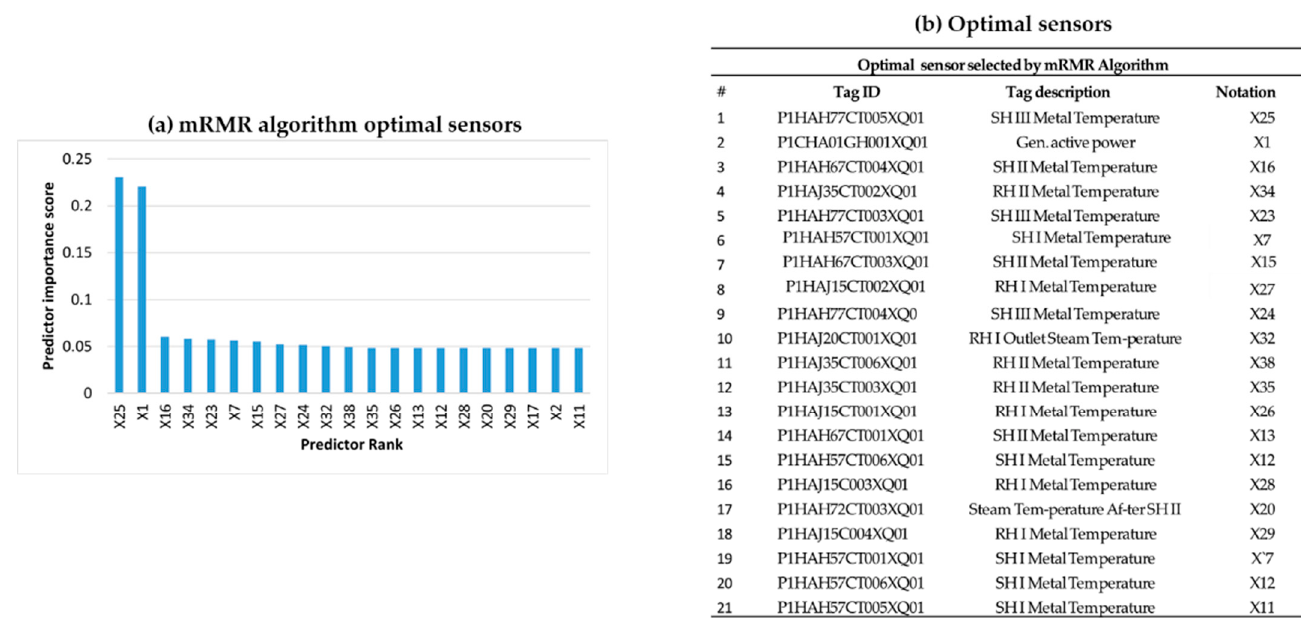
Figure 9. ( a ) mRMR algorithm selected sensors; ( b ) optimal sensors selected by mRMR algorithm.